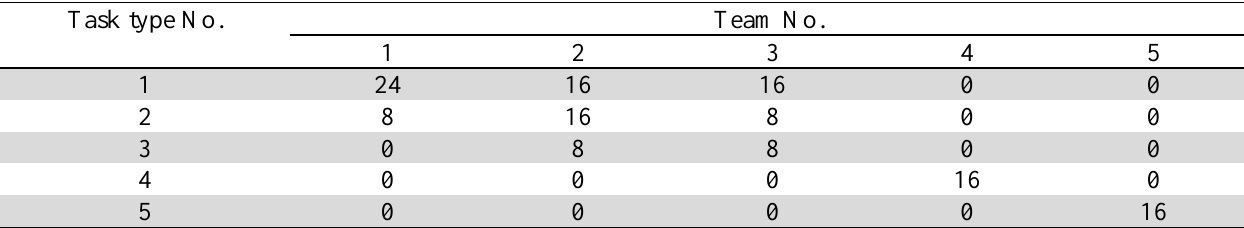
Highest team throughput in hours/day Task type No.